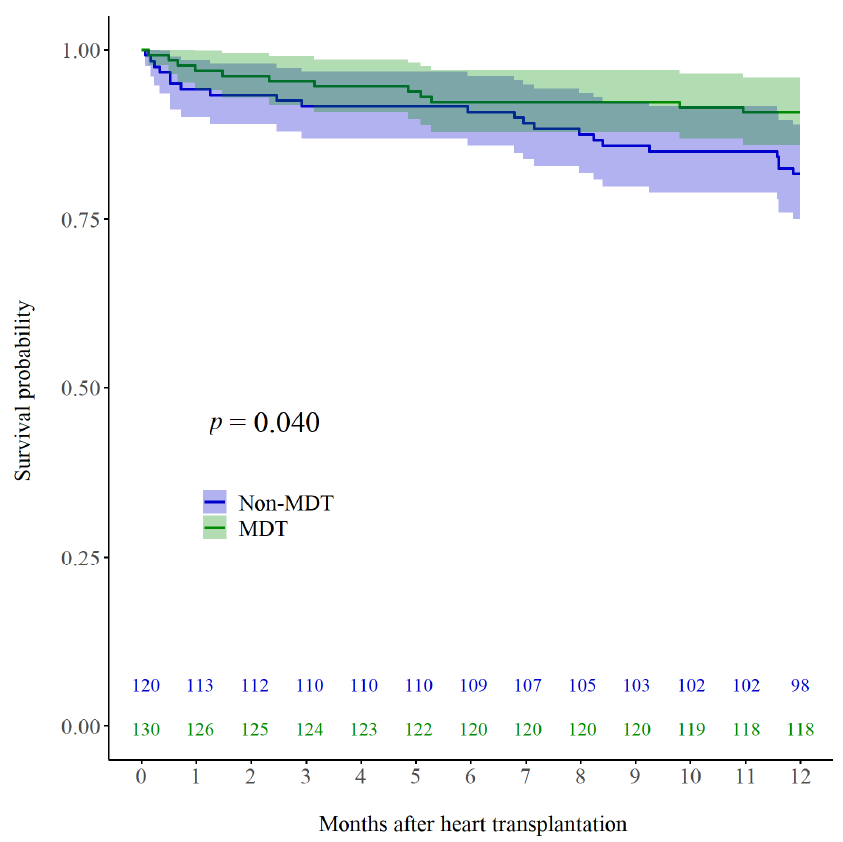
Figure A3. Kaplan–Meier post-heart transplantation survival curves for 1-year survival in patients who underwent heart transplantation with the multidisciplinary team approach (MDT group; green line) and without the multidisciplinary team approach (non-MDT group; blue line). MDT, multidisciplinary team.